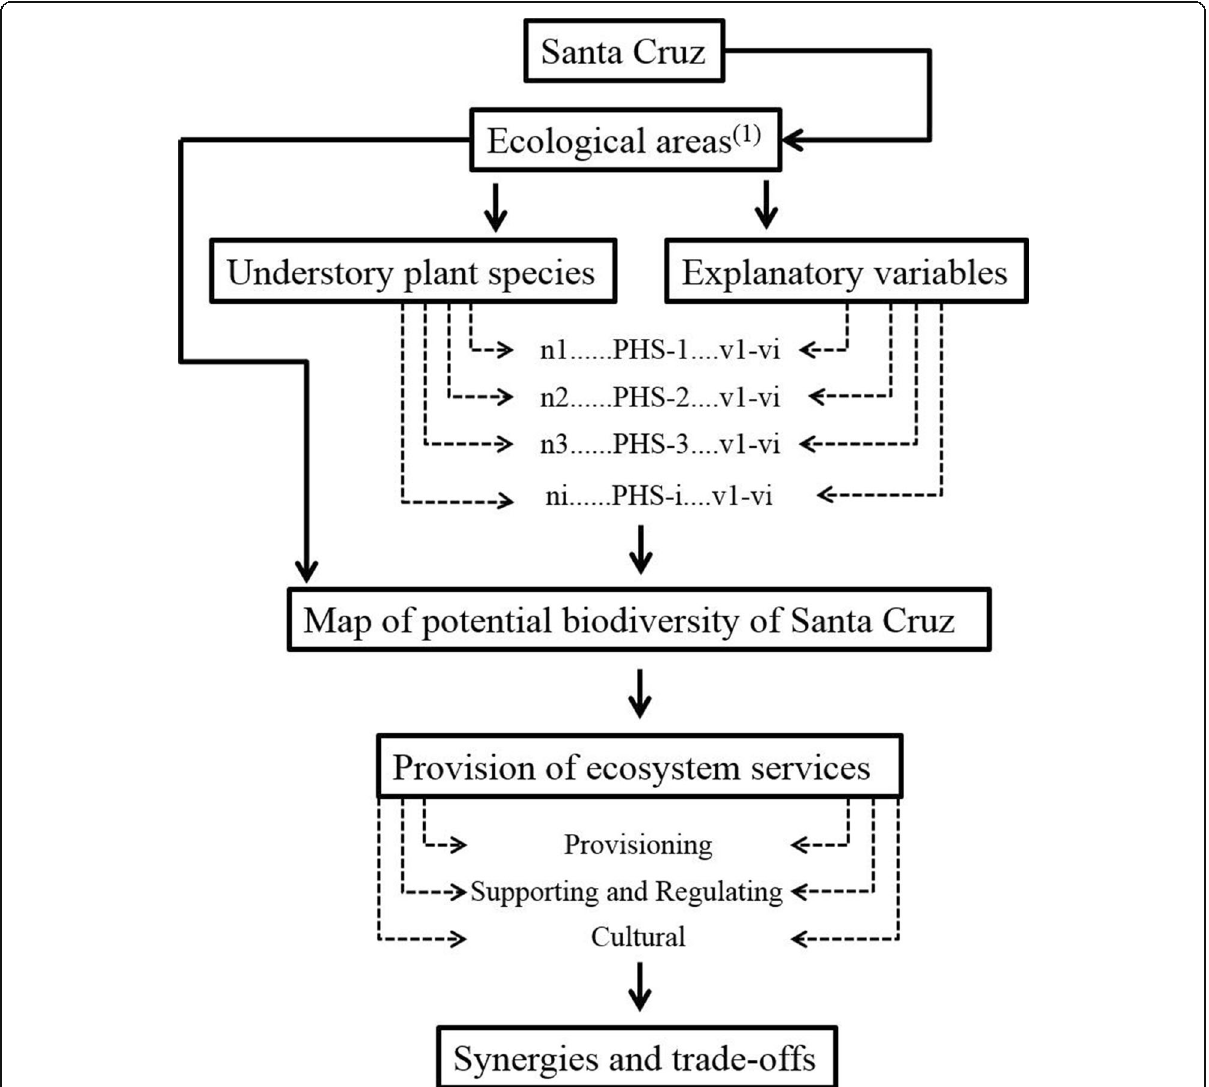
Fig. 2 Chart flow of the methodology, map construction, and analyses based on Martínez Pastur et al. (2016a). (1) Ecological areas followed the proposal of Oliva et al.